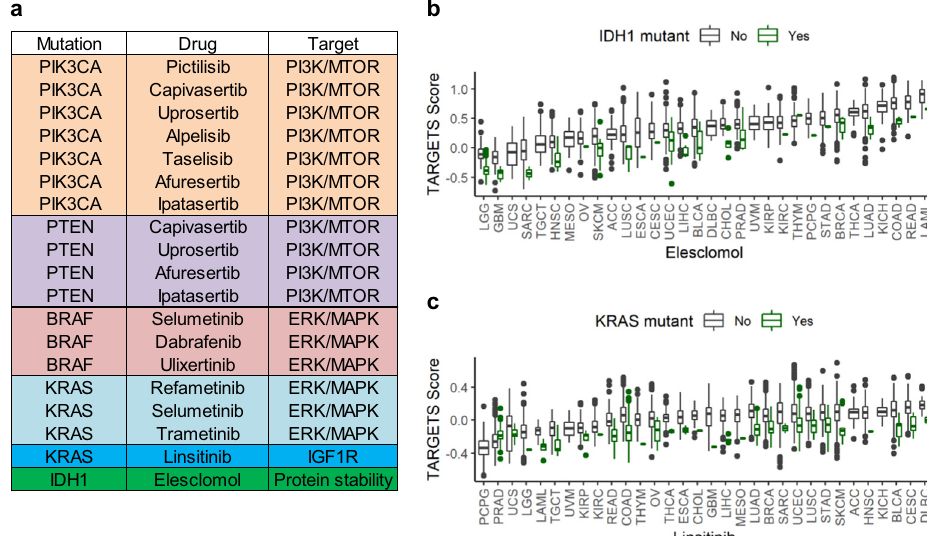
Fig. 5 Novel mutations predicted to confer drug sensitivity. a List of top 1% mutations predicted to confer sensitivity to a speci fi c agent across tumor types. Linear model p -values all <0.0001. The rank is based on the normalized weighting of the model with each model. b Differences in TARGETS scores across 32 cancer types for Linsitinib. c Differences in TARGETS scores across 32 cancer types for Elesclomol. A lower TARGETS score indicates predicted sensitivity. Boxplot center line = median; box limits = upper and lower quartiles; whiskers = 1.5× interquartile